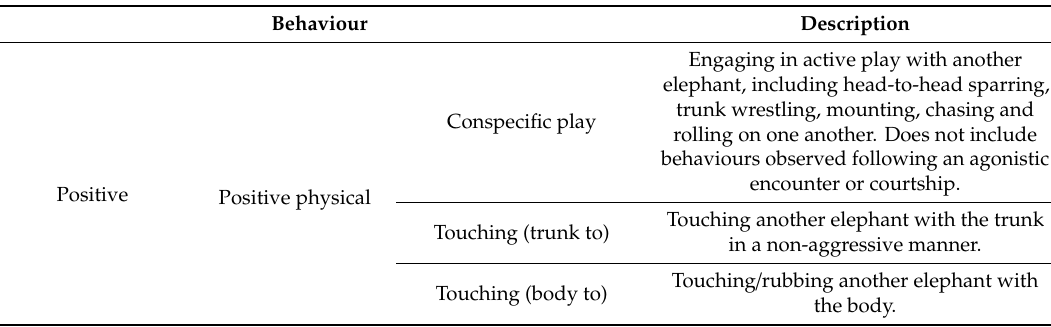
Table 3. Elephant behaviour ethogram